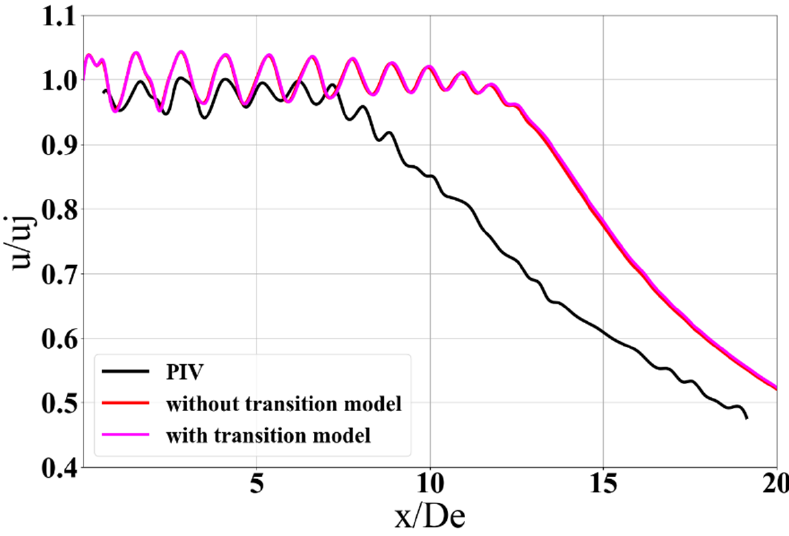
Figure 13. Effect of transition model on jet centerline velocity compared with PIV data from [60].